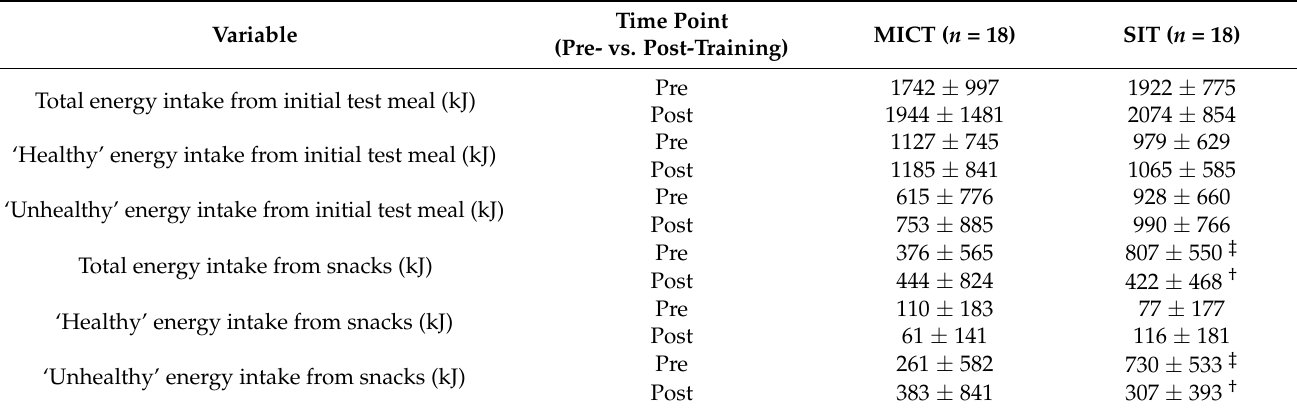
Table 5. Energy intake from a laboratory test meal (initial 30 min) and from snacks (following 2.5 h) following 30 min of SIT or MICT performed pre- and post- 12 weeks of